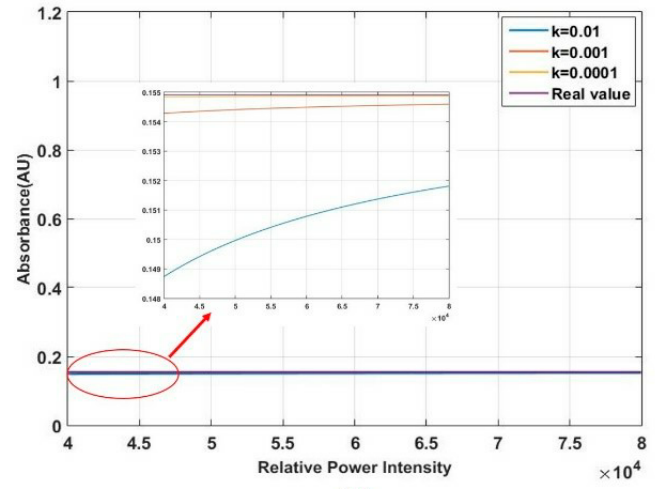
Figure 6. Influence of stray light on the high-energy wavelength Band.